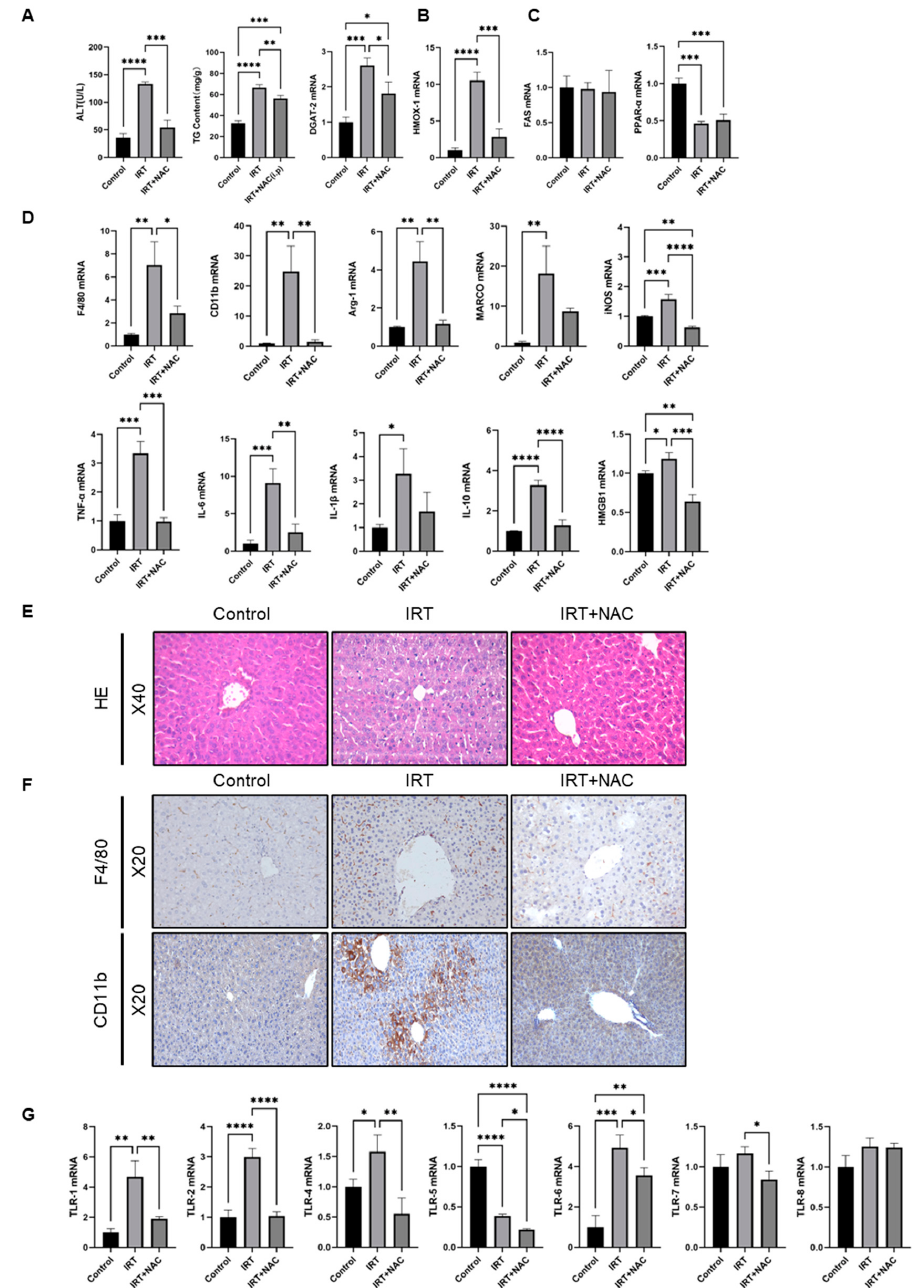
Figure 7. NAC ameliorates irinotecan ‐ induced liver injury under in vivo conditions . Mice in the IRT group were injected intraperitoneally with irinotecan hydrochloride (60 mg/kg), and mice in the NAC group were simultaneously injected intraperitoneally with NAC (100 mg/kg) on the following day, alternately for 2 weeks, and liver injury was measured on day 15. ( A ) Changes in ALT levels, TG content, and mRNA expression of DGAT ‐ 2 in mice after NAC intervention. ( B ) Changes in mRNA expression of HMOX ‐ 1 in mice after NAC intervention. ( C ) Changes in mRNA expression of FAS and PPAR ‐α in mice after NAC intervention. ( D ) Changes in mRNA expression of F4/80, CD11b, Arg ‐ 1, MARCO, iNOS, TNF ‐α , IL ‐ 6, IL ‐ 1 β , IL ‐ 10, and HMGB1 in mice after irinotecan